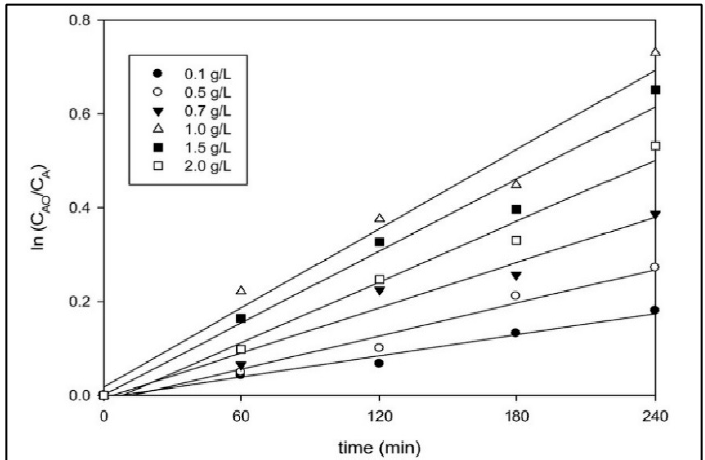
Figure 21. Reaction kinetic plots for photocatalytic degradation of POME. Reproduced from ref. [118] with permission from The Royal Society of Chemistry.